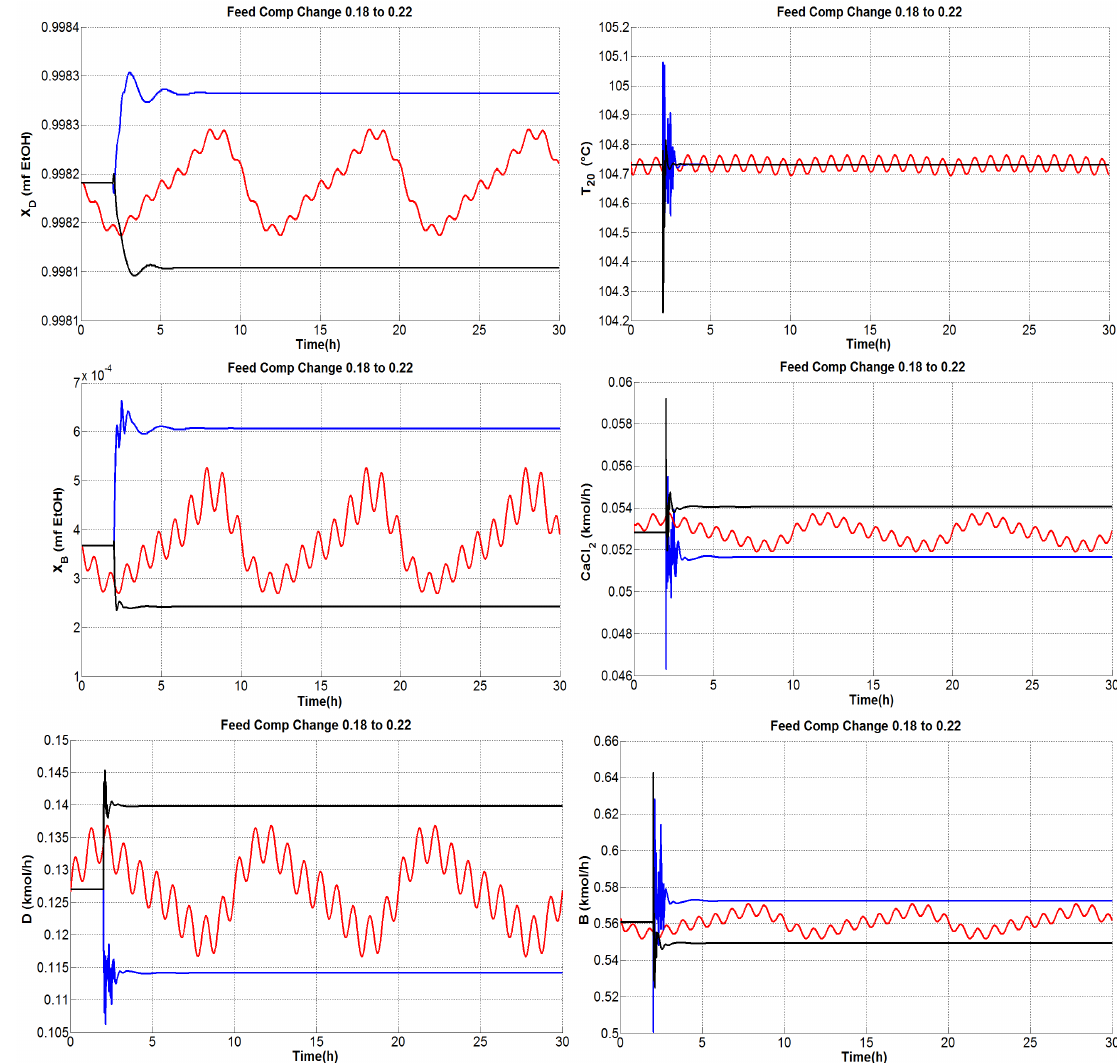
Figure 14. Performance of the R/F structure for single-end mode temperature control, assuming step perturbations of the feed molar fraction with amplitude of 10% (black) and − 10% (blue) with respect to the nominal value, and a continuous fluctuating perturbation (red).